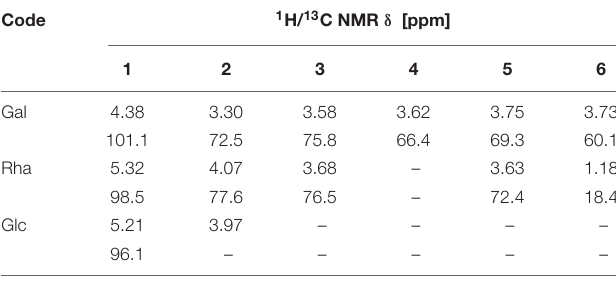
TABLE 3 | Chemical shift assignment of K-CMLP.